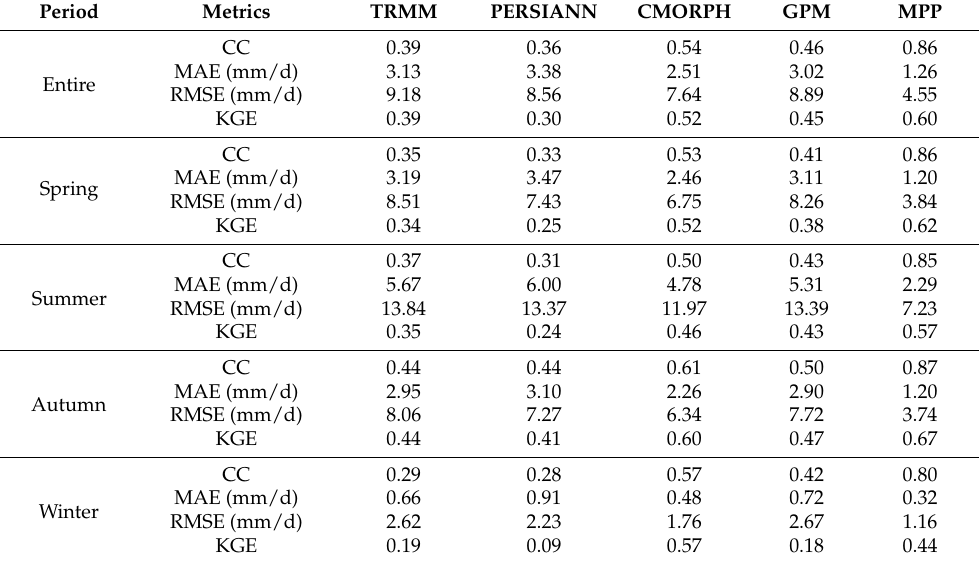
Table 4. CC, MAE, RMSE, and KGE of the MPP and the original four SPPs with reference to gauge observations across the entire period and different seasons from 2007 to 2018. Period Metrics TRMM